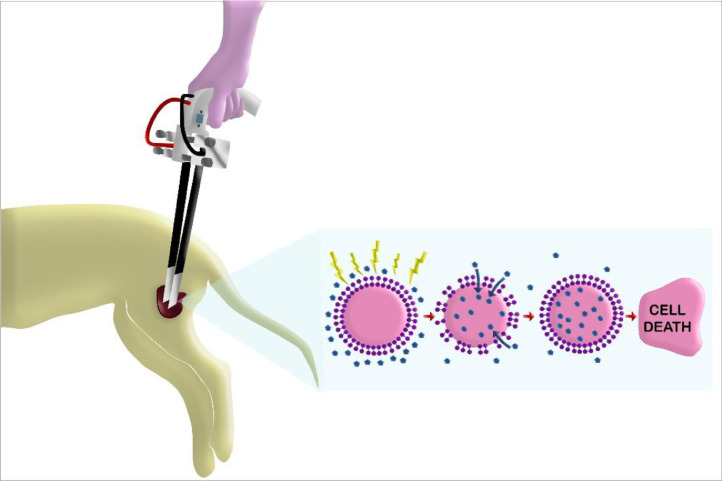
Illustrative schematic of one of the mechanisms of electrochemotherapy (from left to right side). First, the plate electrode covers a part of the cutaneous tumor. Once the electric field is delivered over the tumor by the electroporator (Onkodisruptor®), the electric pulses lead to the creation of nanopores in the cell membrane promoting a movement of large amount of drug (specially lipophobic drugs) into the cell. Resealing of the membrane then occurs once the electric field has stopped, leading to cell death.